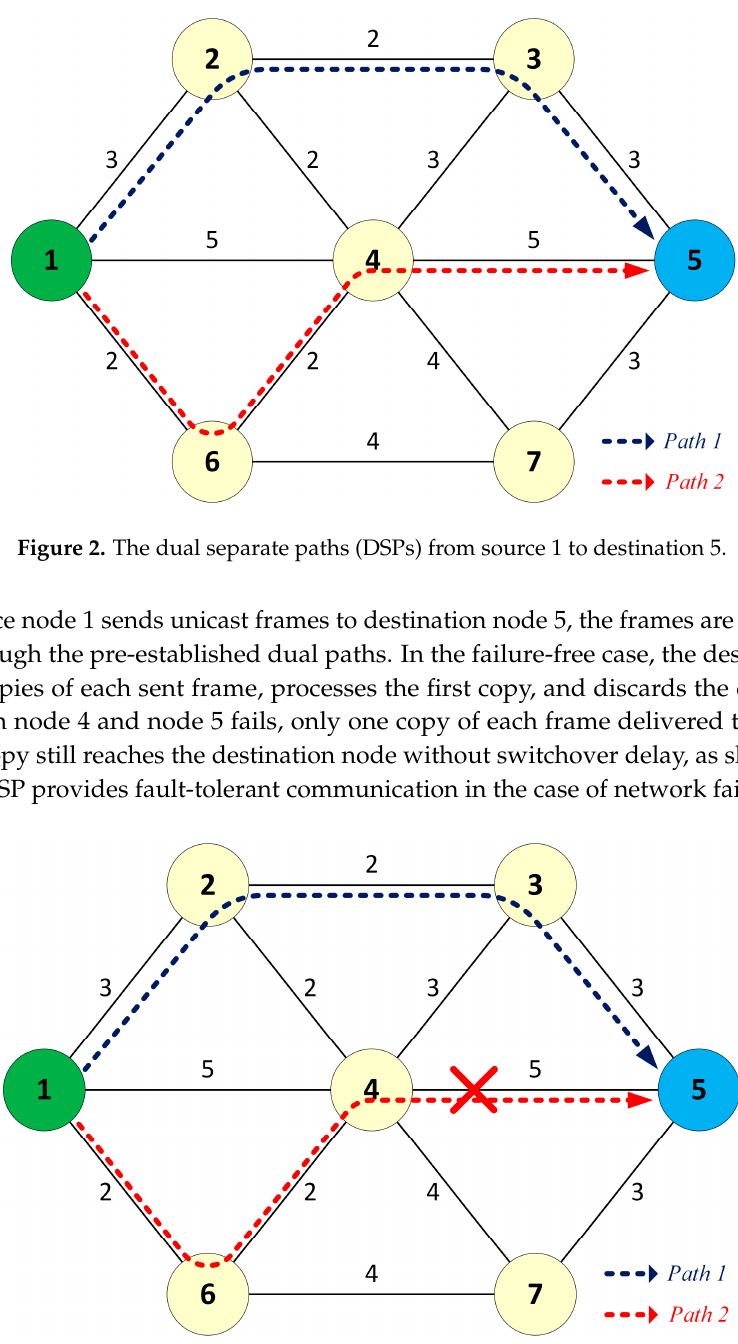
Table 2. The selected dual paths from source 1 to destination 5.